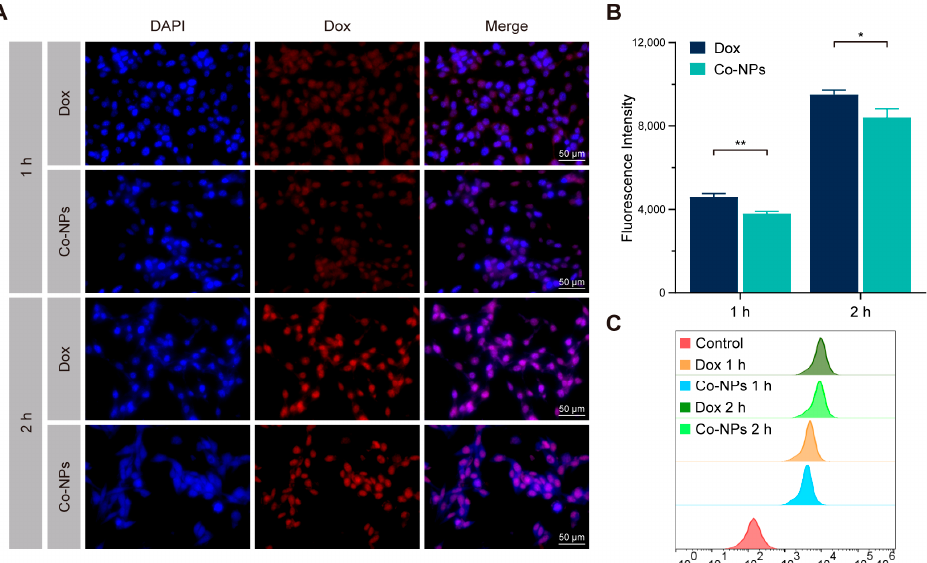
Figure 2. In vitro cellular uptake. ( A ) Cellular uptake of free Dox and Co-NPs after incubation with B16F10 cells for 1 h and 2 h. Scale bar = 50 μ m. ( B , C ) Quantitative analysis of cellular uptake of free Dox and Co-NPs by B16F10 cells using FCM ( n = 3). (* p < 0.05, ** p < 0.01).